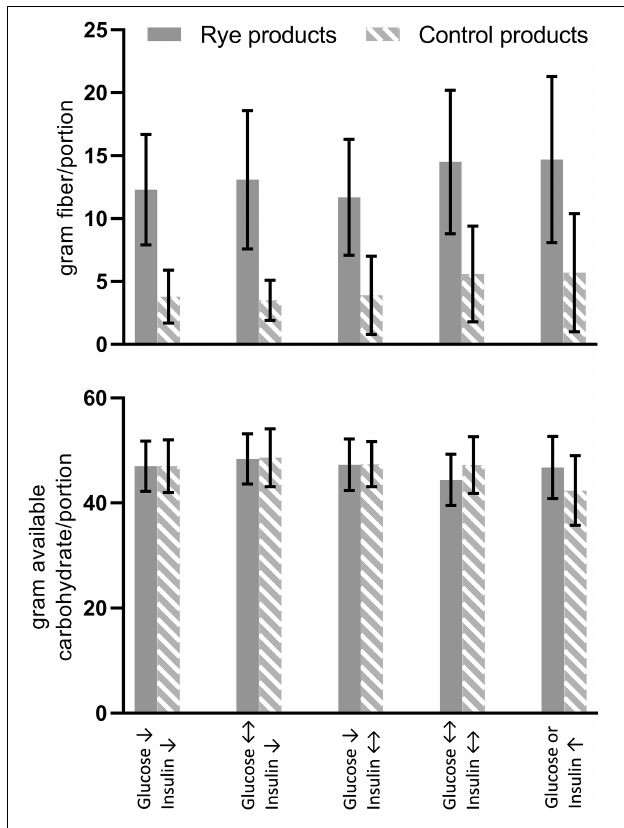
FIGURE 1 | Total dietary fiber and available dietary fiber content of rye products and control products, categorized according to effect on postprandial glucose and insulin ( Table 1 ). Data is mean and standard